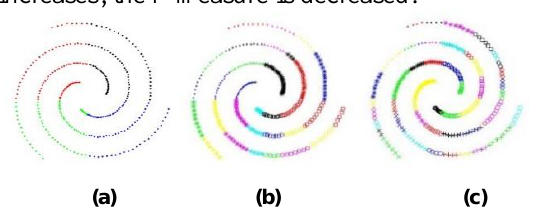
Figure 9. HUALM on spiral dataset reaches an accuracy of one after three levels, but with the number of clusters